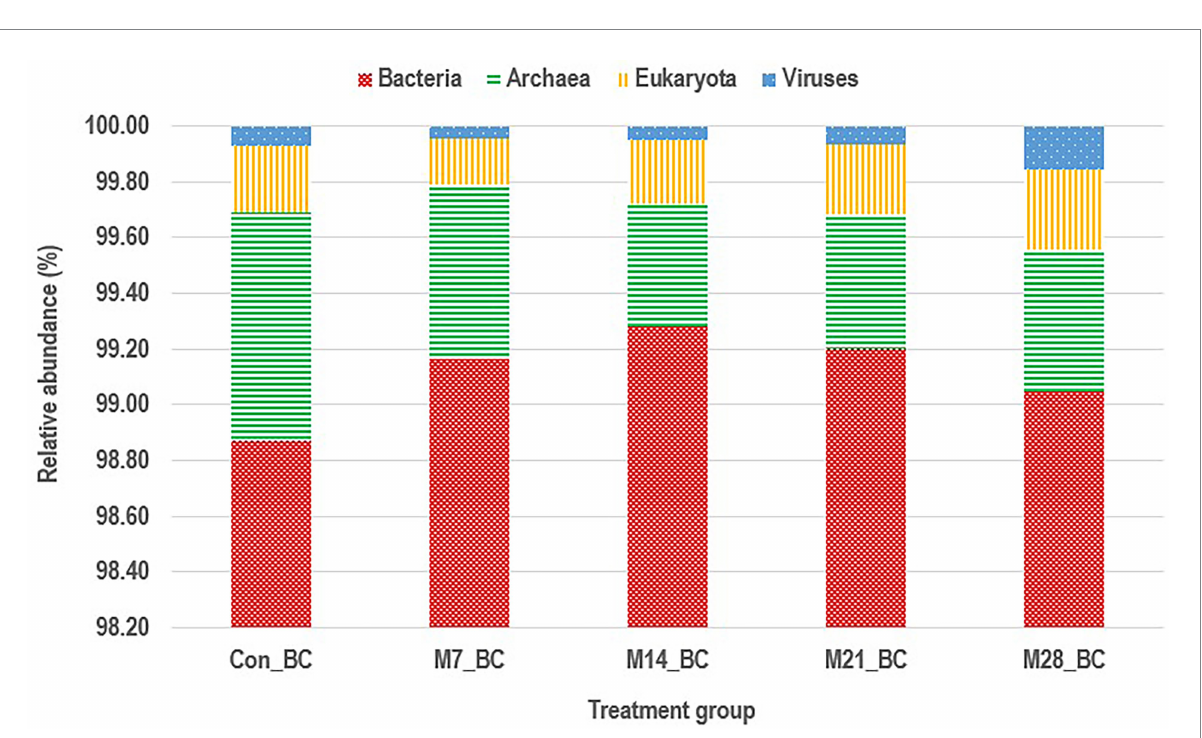
FIGURE 2 Stacked bar chart showing the major domain of microbial communities in caecum digesta samples from broiler chickens fed with diets containing different levels of marama bean meal [Treatment groups: 0% (Con_BC); 7% (M7_BC); 14% (M14_BC); 21% (M21_BC); 28% (M28_BC) inclusion